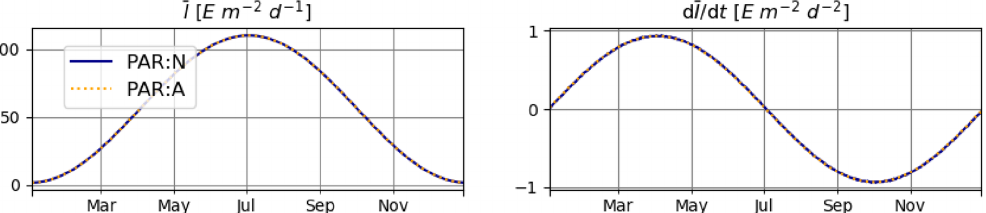
Figure 1. Daily average irradiance and its temporal derivative, as extracted from the simulation outputs generated for T1. PAR:N (solid blue line) is the model version where the temporal derivative of irradiance is approximated numerically; PAR:A (dashed orange line): both irradiance and its temporal derivative are calculated